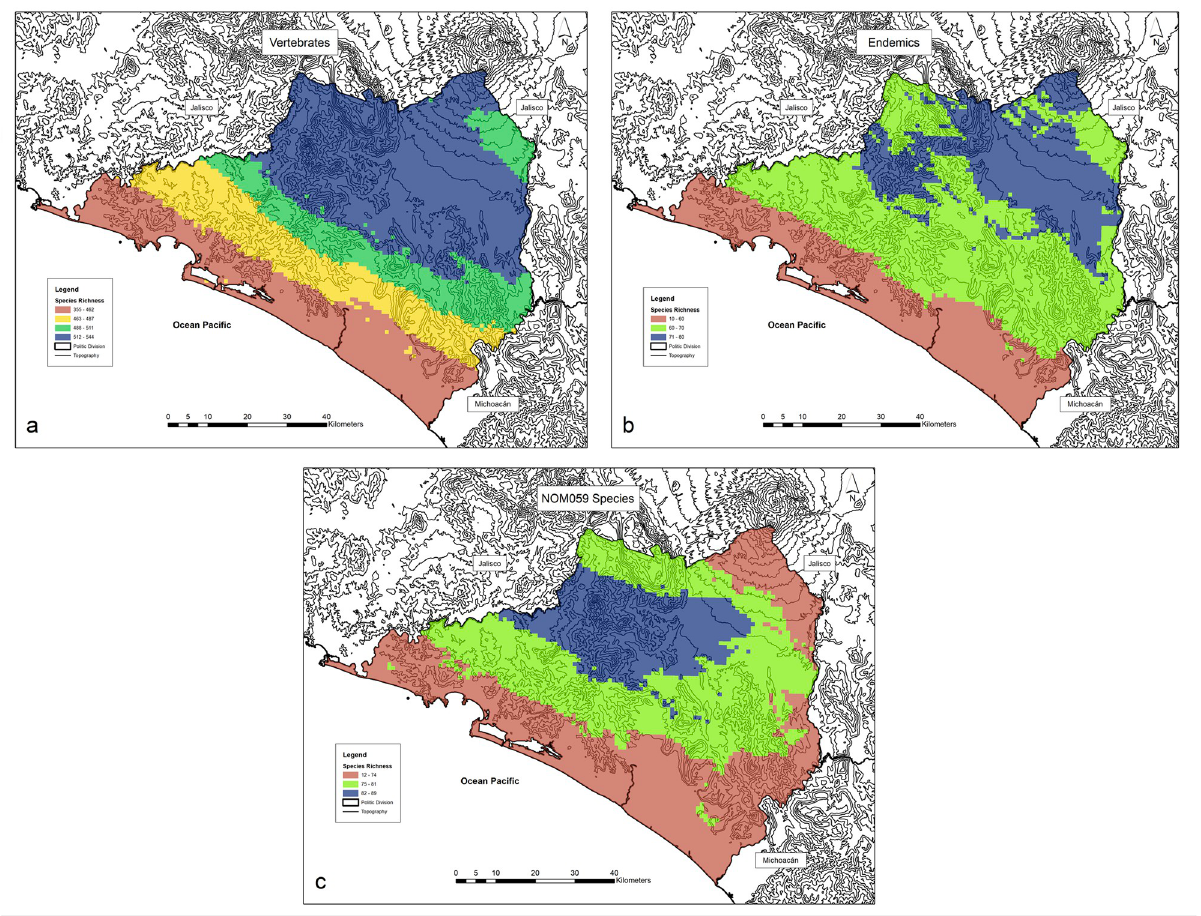
Fig 3. Spatial distribution patterns of (a) vertebrate total species richness, (b) endemic species and (c) threatened species for Colima, Mexico. Note the higher concentration of species in the central and northern regions of the state and the clear gradient for total vertebrate richness. Maps were created